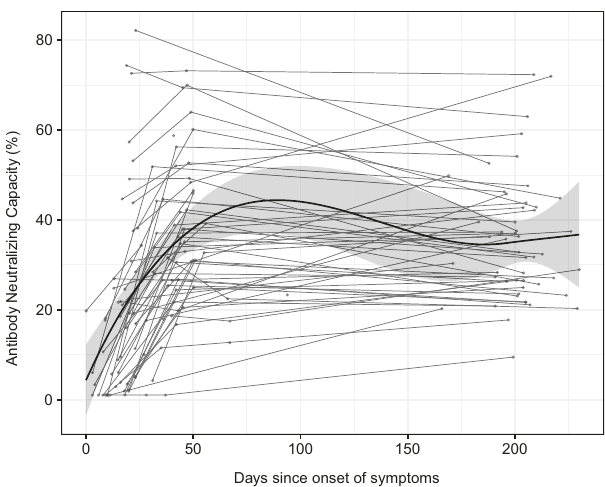
Fig. 2 Longitudinal antibody neutralizing capacity. Antibody neutralizing capacity, as a percentage of RBD-ACE2 binding inhibition in plasma samples from 64 symptomatic participants collected in three serial visits (M0, M1, and M6) represented as days after symptom onset. Paired samples are joined by gray lines. The black solid line represents the fi tted curve calculated using the LOESS (locally estimated scatterplot smoothing) method. Shaded areas represent 95% con fi dence